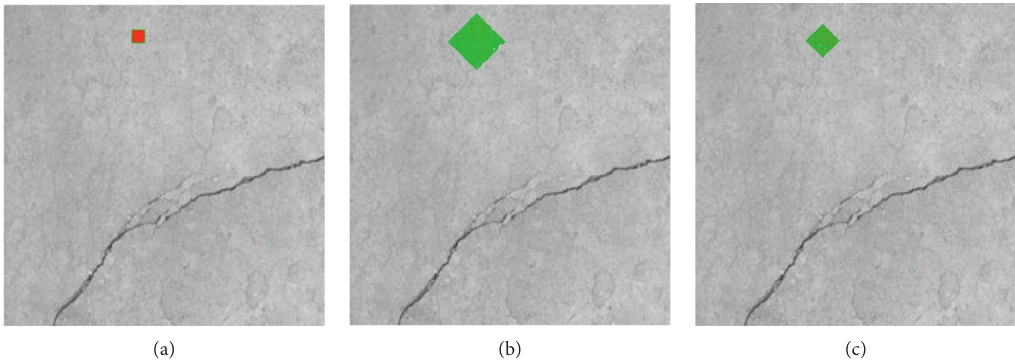
Figure 10: Percolation regions of pixel (20, 100) in image crack 5: (a) raw image; (b) without termination; (c) with